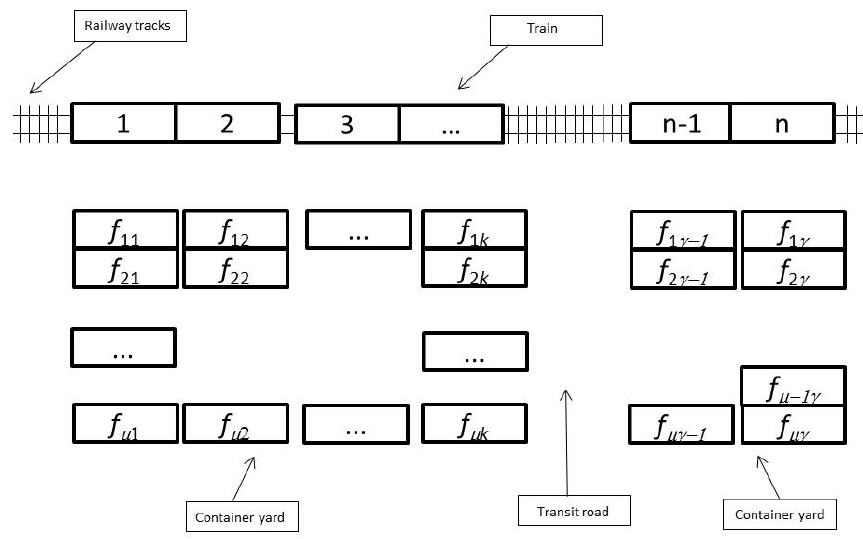
Figure 1. Diagram of the field designations in the storage yard.